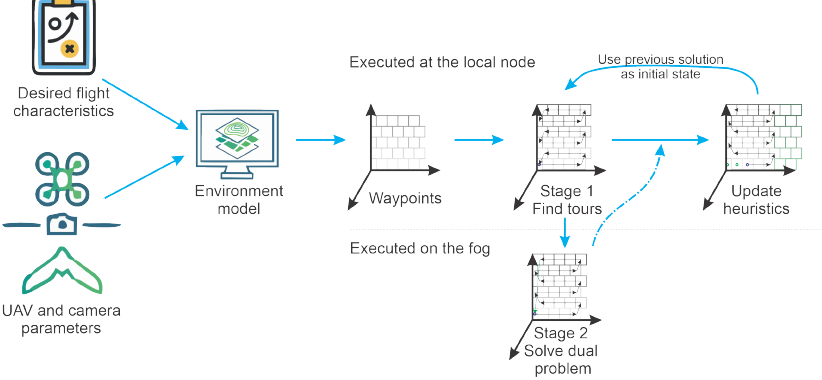
Figure 7. Optimization model